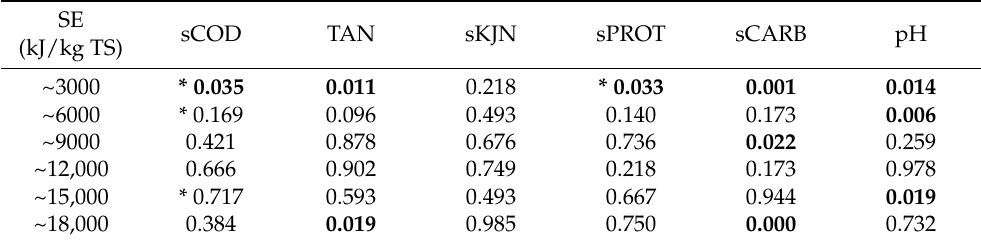
Table 5. ANOVA results for the efficiency of US disintegration per digestate age. Bold p -values are